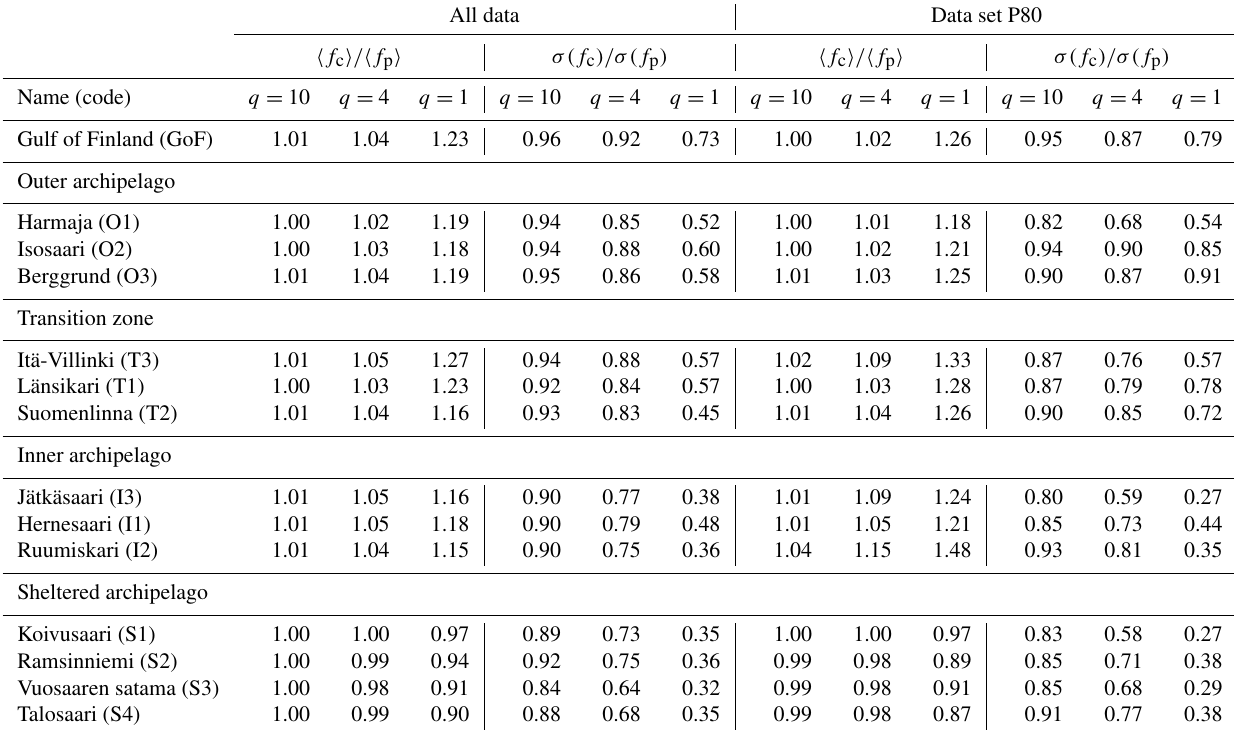
Table 4. The mean values and the scatter (standard deviation) of the characteristic wave frequency f c := f q p for three different values of q (see Eq. 6) compared to that of the peak frequency, f p . Note that f q p = f m for q = 1. All data Data set P80 (cid:104) f c (cid:105) / (cid:104) f p (cid:105) σ(f c )/σ(f p ) (cid:104) f c (cid:105) / (cid:104) f p